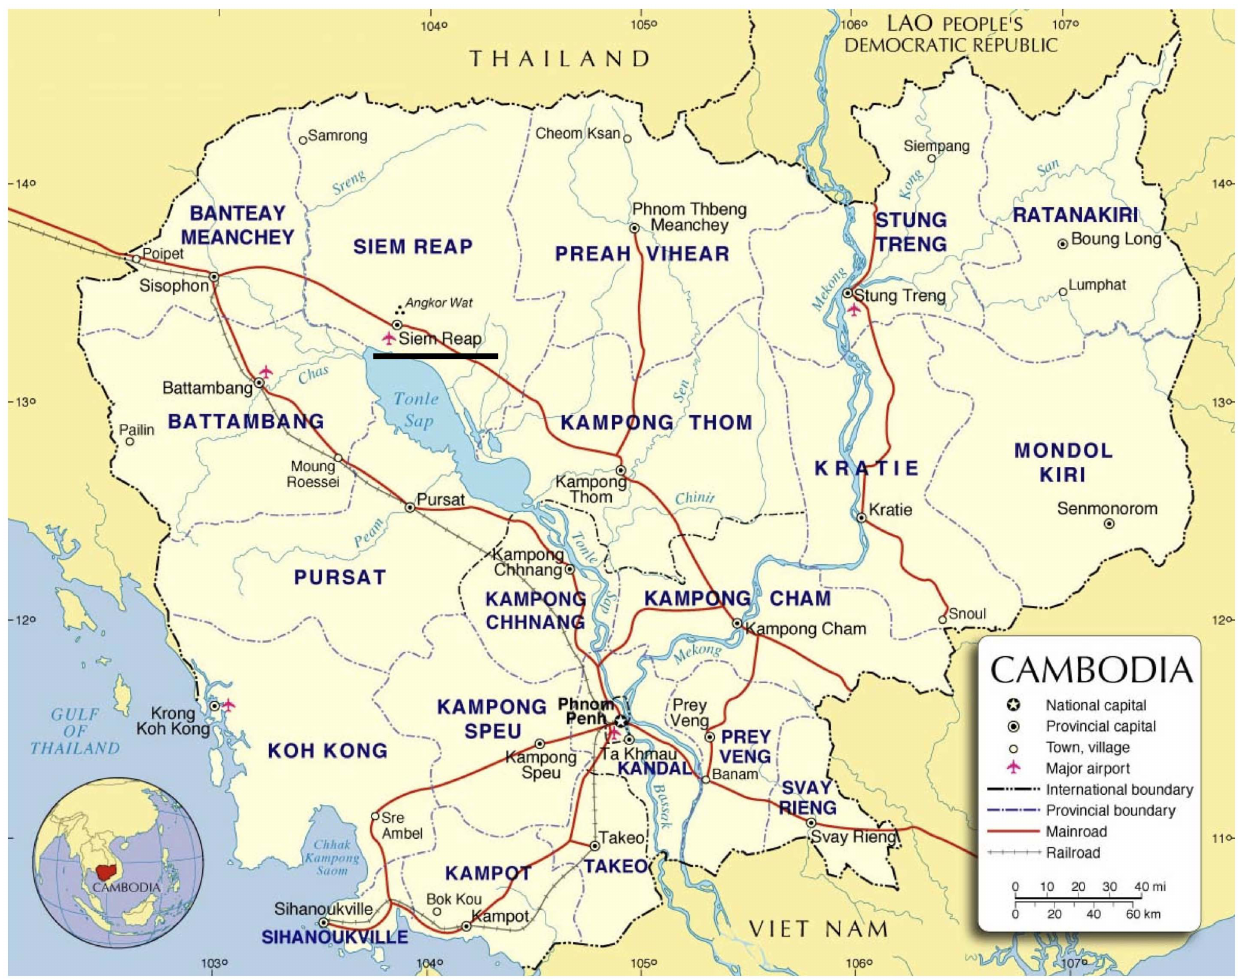
Figure 1. Location and map of Cambodia. AHC is in Siem Reap (underlined). Map: United Nations, 2004 (http://www.un.org/Depts/Cartographic/ map/profile/cambodia.pdf). Accessed 2nd January 2013.